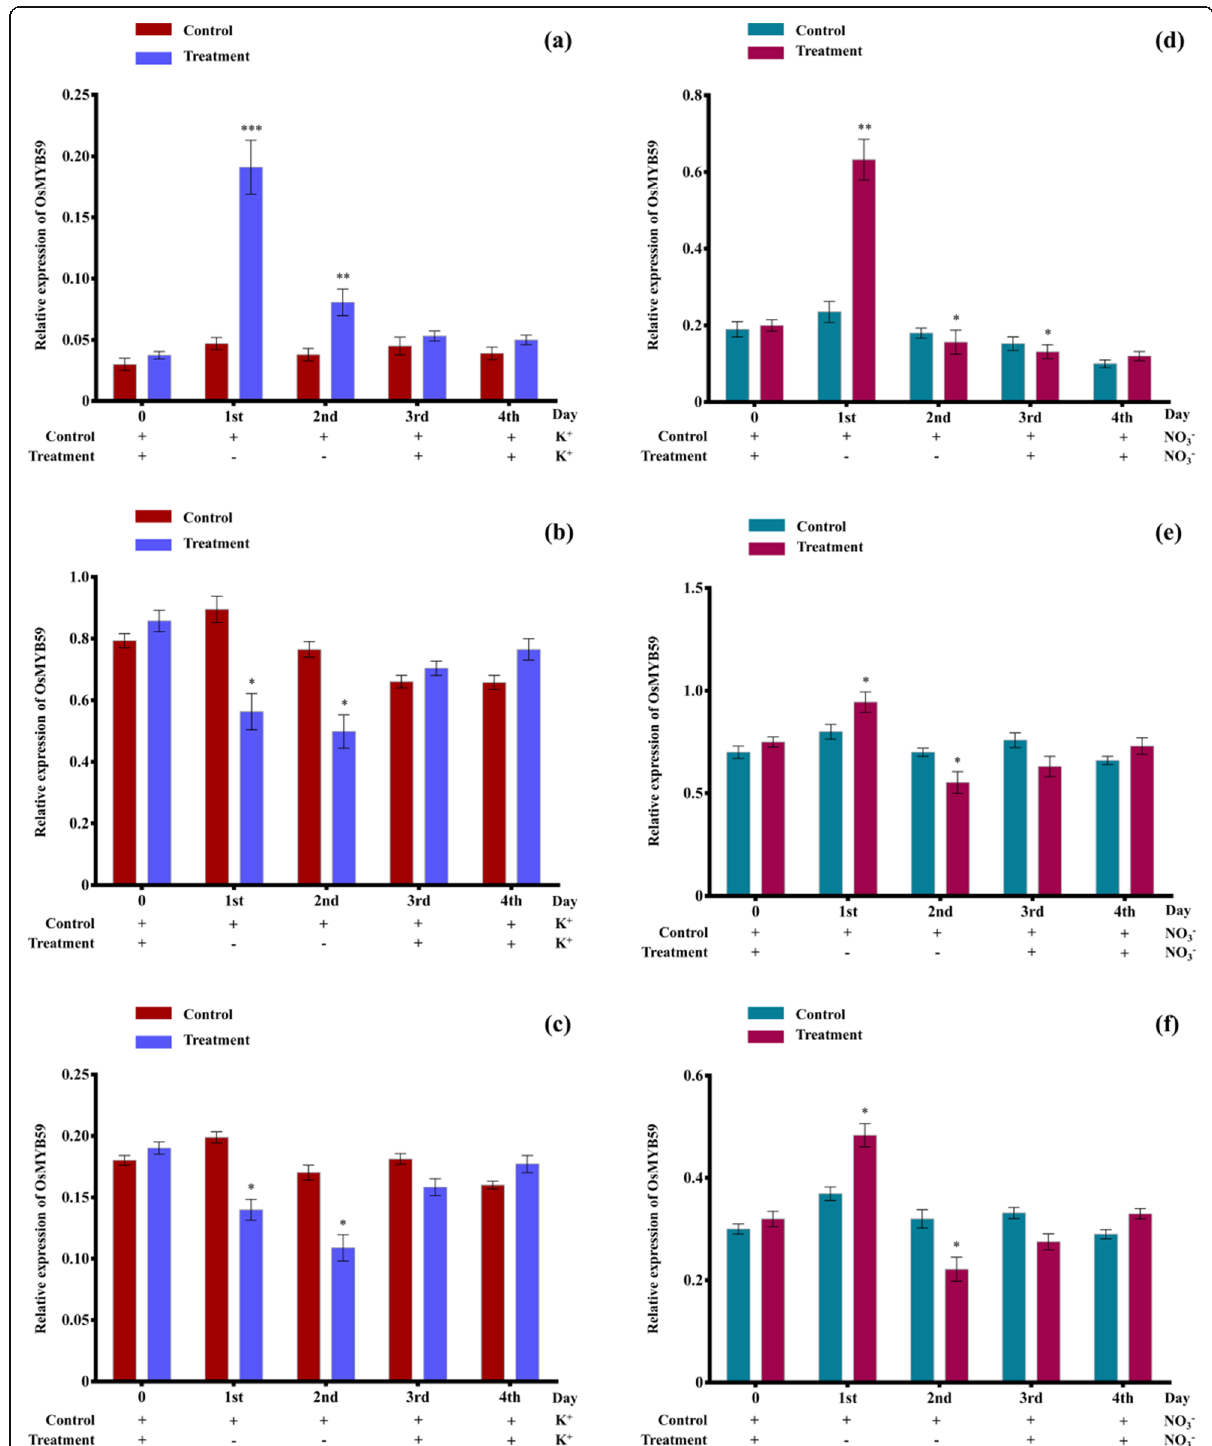
Fig. 6 OsMYB59 indica transcription responds to external K + levels in BRRI dhan56 ( a ), BRRI dhan48 ( b ), BRRI dhan71 ( c ), and external NO 3 − levels in BRRI dhan56 ( d ), BRRI dhan48 ( e ), and BRRI dhan71 ( f ). Plus (+) and minus ( − ) symbols represent sufficient and deficient conditions, respectively. RT-qPCR data are shown as means ± SE. Differences between the values of treatments and controls were compared using t tests (* p < 0.05, ** p < 0.01, and *** p <